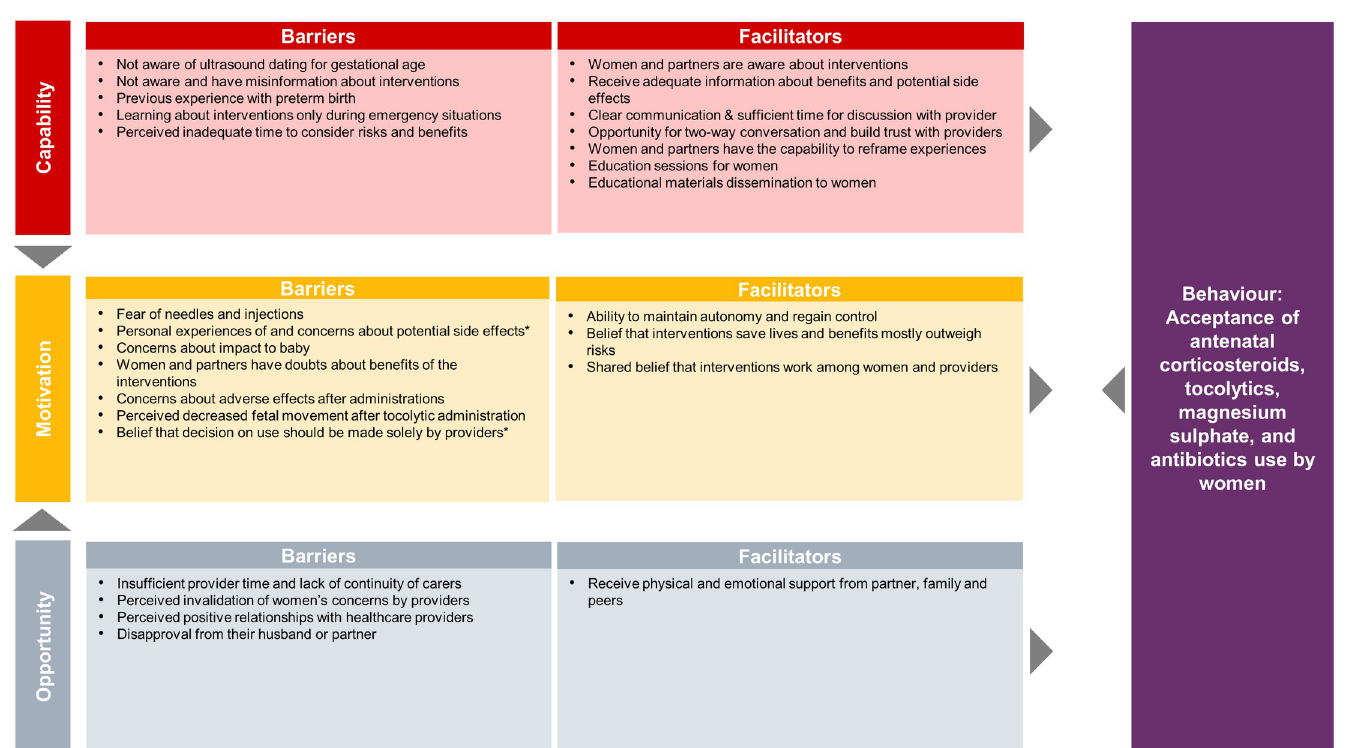
Fig 6. Mapping factors affecting women’s acceptability to receive interventions for preterm birth management using COM-B. � = mixed evidence, could be facilitators and barriers.